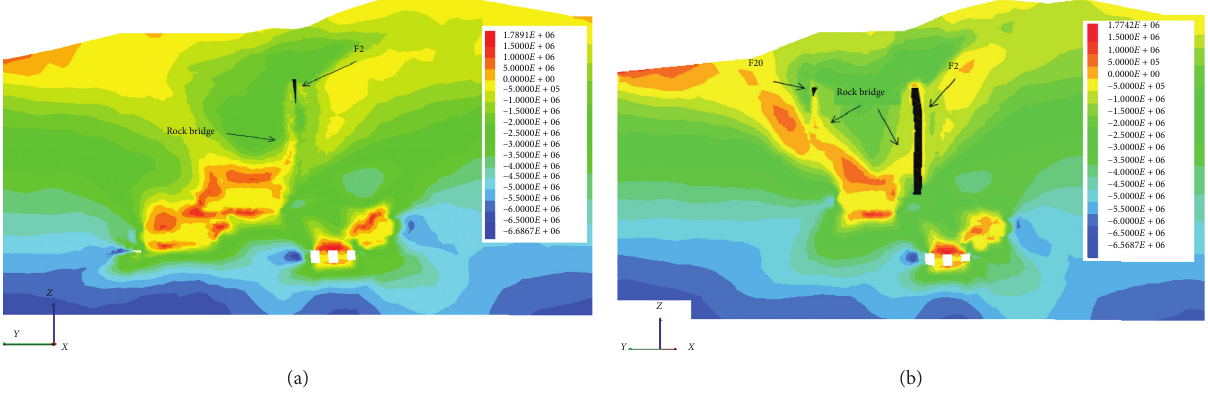
Figure 12: Stress distribution diagram of model section (Pa). (a) Section 1. (b) Section 2.